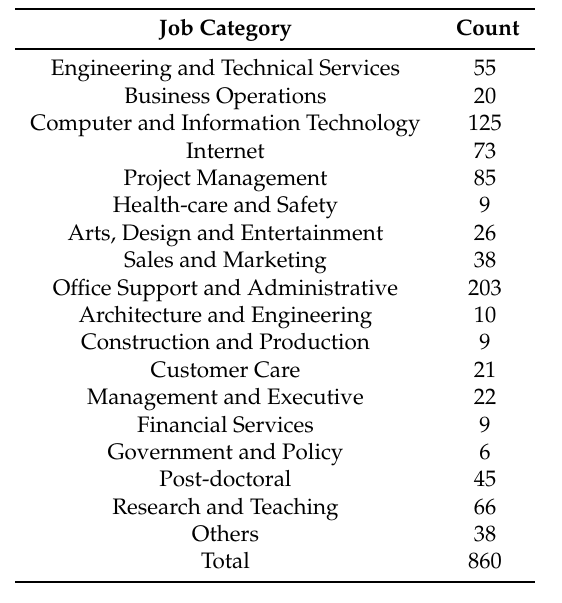
Table 10. Statistics of job descriptions in various job categories collected